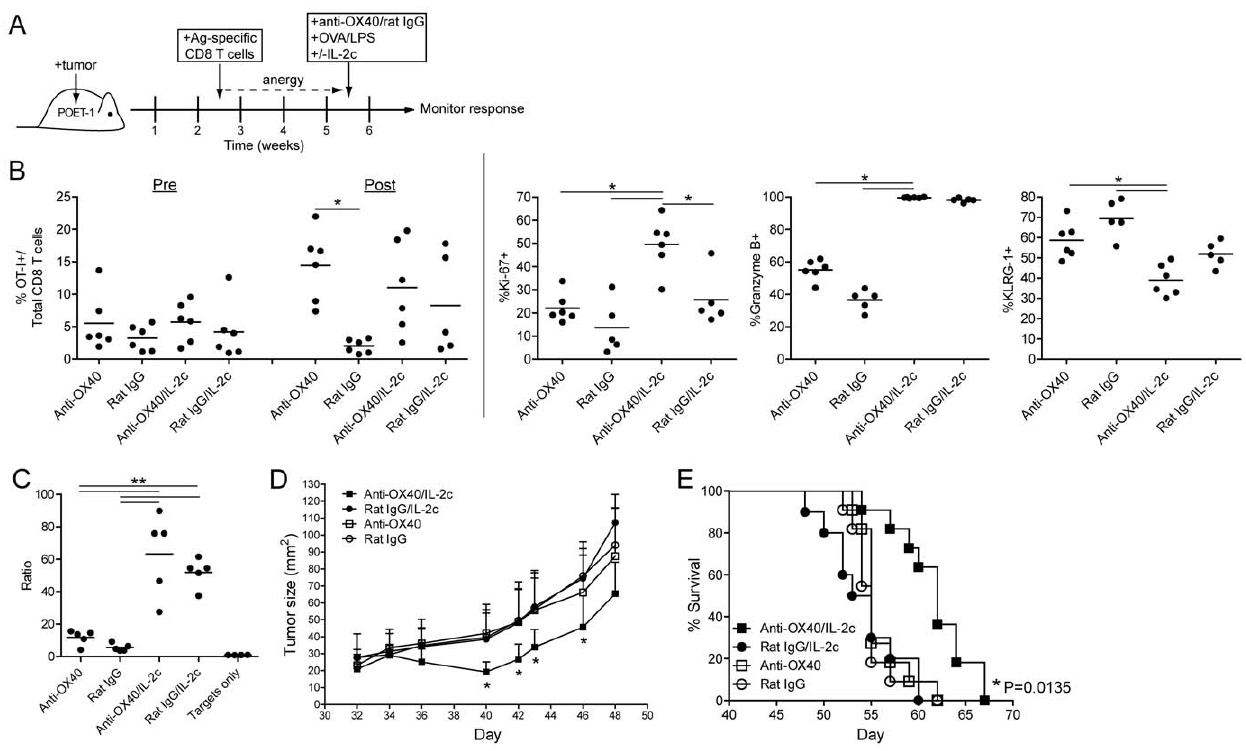
Figure 8. Dual anti-OX40/IL-2c therapy reverses CD8 T cell anergy and increases the survival of mice with long-term well- established tumors. A ) Tumor model. 2.5 6 10 6 TRAMP-C1-mOVA tumor cells were injected into POET-1 mice. Twenty days later, mice ( , 50 mm 2 tumors) received 5 6 10 5 naı¨ve OT-I T cells. Seventeen days after T cell adoptive transfer (37 days post-tumor inoculation), the anergic donor OT-I T cells were re-stimulated with anti-OX40 or control (rat IgG) Ab (d37-38), 500 mcg OVA (d37), 10 mcg LPS (d37), + / 2 IL-2 cytokine/mAb complexes (d37-44). B ) Seven days after the initial dose of Ag/anti-OX40 the extent of donor CD8 T cell expansion (% OT-I of total CD8 T cells; pre- vs. post- treatment), Ki-67 (proliferation), granzyme B, and KLRG-1 expression on the donor OT-I T cells were determined. C ) Tumor-bearing mice were treated as in ( B ) and then seven days later OVA peptide-pulsed (CFSE high ) and control HA peptide-pulsed (CFSE low ) target cells were mixed at a 1:1 ratio and injected into recipient mice. Four hours later, spleens were harvested and the ratio of % CFSE low /% CFSE high target cells from individual mice (n=5/ group) was determined. D, E ) The extent of tumor growth (mean + / 2 SD; n=5/group) and D ) survival (n=11/group) of tumor-bearing mice were assessed. Data are representative of one out of 2 to 3 independent experiments or E ) the cumulative survival from 2 independent experiments. *P , 0.05, **P , 0.01.